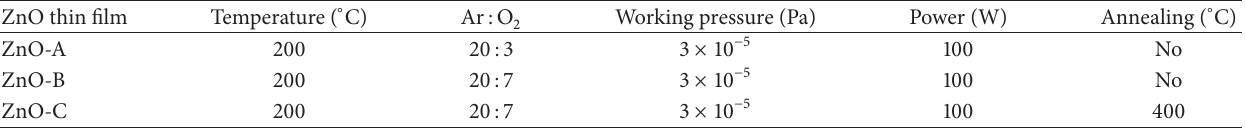
Figure 8: SEM images of ZnO nanorods and corresponding substrates. (a) Unmodified ITO substrate, (b) top view, (c) side view of ZnO nanorods grown on unmodified substrate, (d) PPT-substrate, (e) top view, and (f) side view of ZnO nanorods grown on PPT-substrate. Growth time: 2 h (reproduced with the permission from [47]). Table 1: Detailed preparing parameters to grow different ZnO seed layers on Si substrates